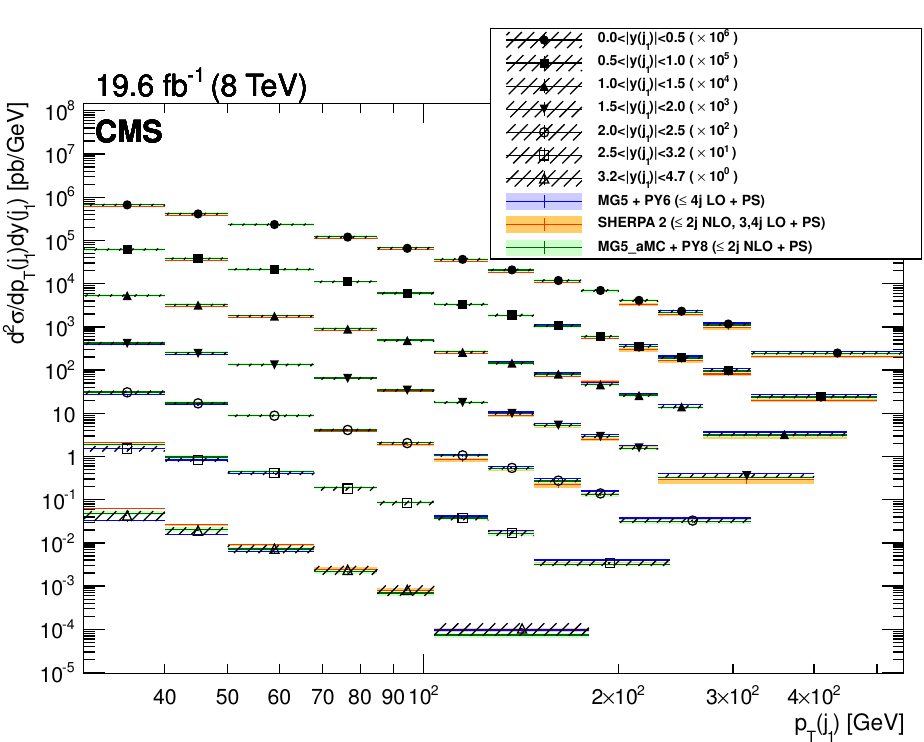
Figure 29 . The di(cid:11)erential cross section for Z ( ! ‘‘ ) + jets production as a function of the leading jet transverse momentum and rapidity. The bands around the measurement points represent the total measurement uncertainties. The bands around the prediction points represent the total uncertainty, and its statistical, theoretical, and PDF components for mg5 a mc + pythia 8, and the statistical uncertainty alone for MadGraph 5 + pythia 6 and sherpa